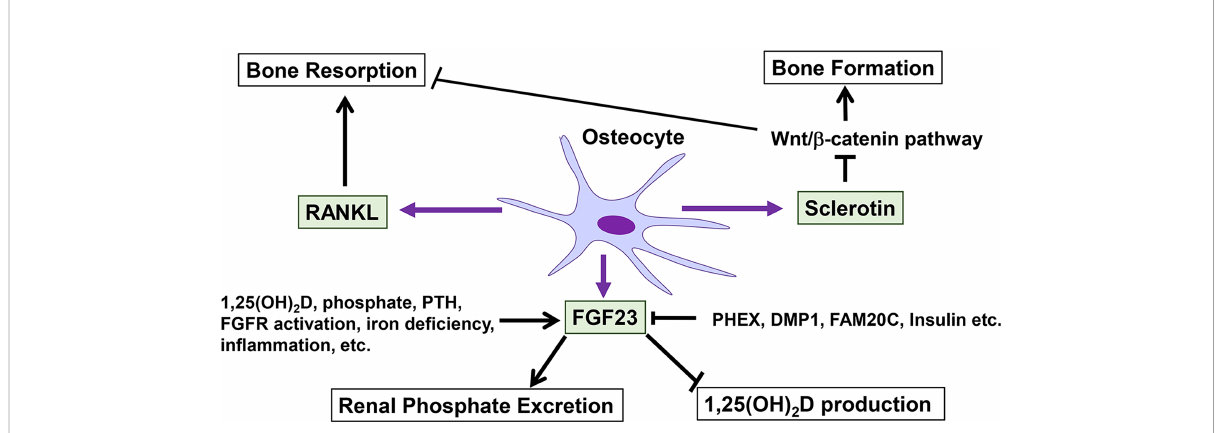
FIGURE 1 Roles of osteocytes in the control of bone mass and the regulation of phosphate metabolism. Osteocytes regulate bone formation and resorption through the production of sclerostin and RANKL. Sclerostin suppresses bone formation by inhibiting Wnt/ b -catenin signaling. FGF23 produced by osteocytes plays central roles in phosphate metabolism by increasing renal phosphate excretion and decreasing the production of 1,25(OH) 2 D. The production of FGF23 in osteocytes is in fl uenced by various positive and negative